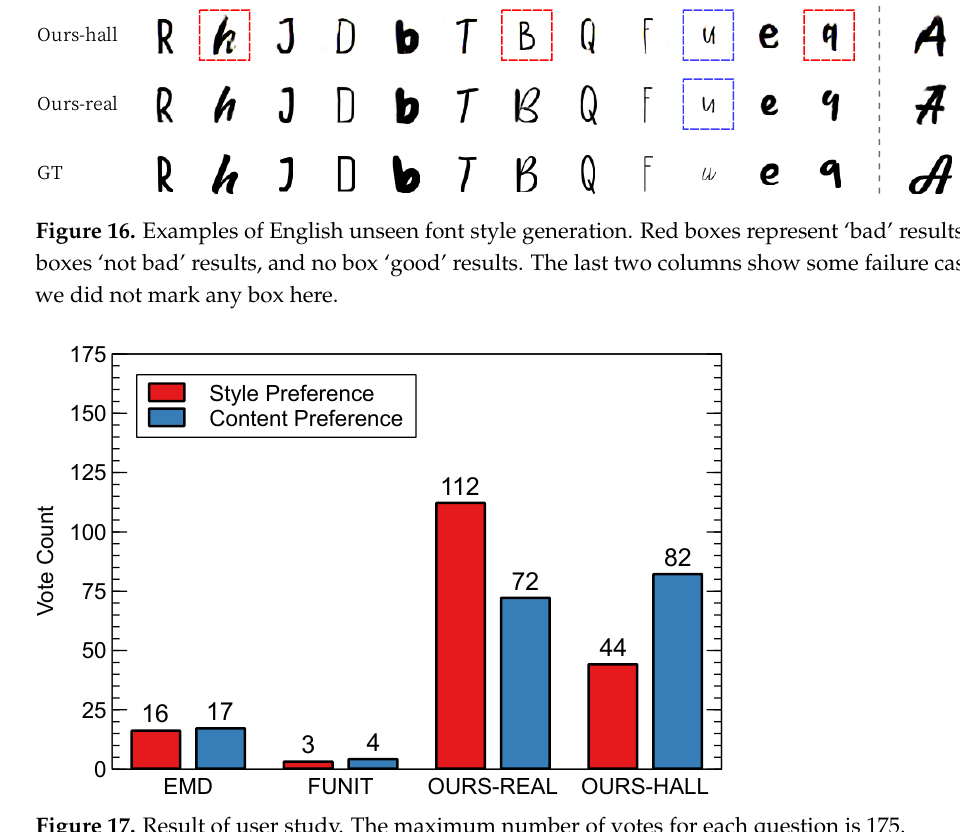
Figure 17. Result of user study. The maximum number of votes for each question is